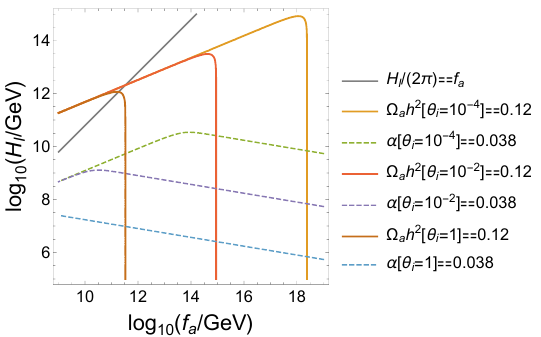
Figure 4. Constrains from dark matter abundance and isocurvature spectrum, for QCD axions produced in PQ broken scenario. Reproduced from [83]. The solid lines present when axions constitute all the dark matter, and the region below the line is the parameter space allowed. The dashed lines present contribution of axion perturbations, constrained by isocurvature ratio α = A I,a /A s < 0 . 038 , and the region below is allowed. The three groups of lines are for different initial misalignment angle θ . The condition for PQ broken scenario corresponds to below the grey i